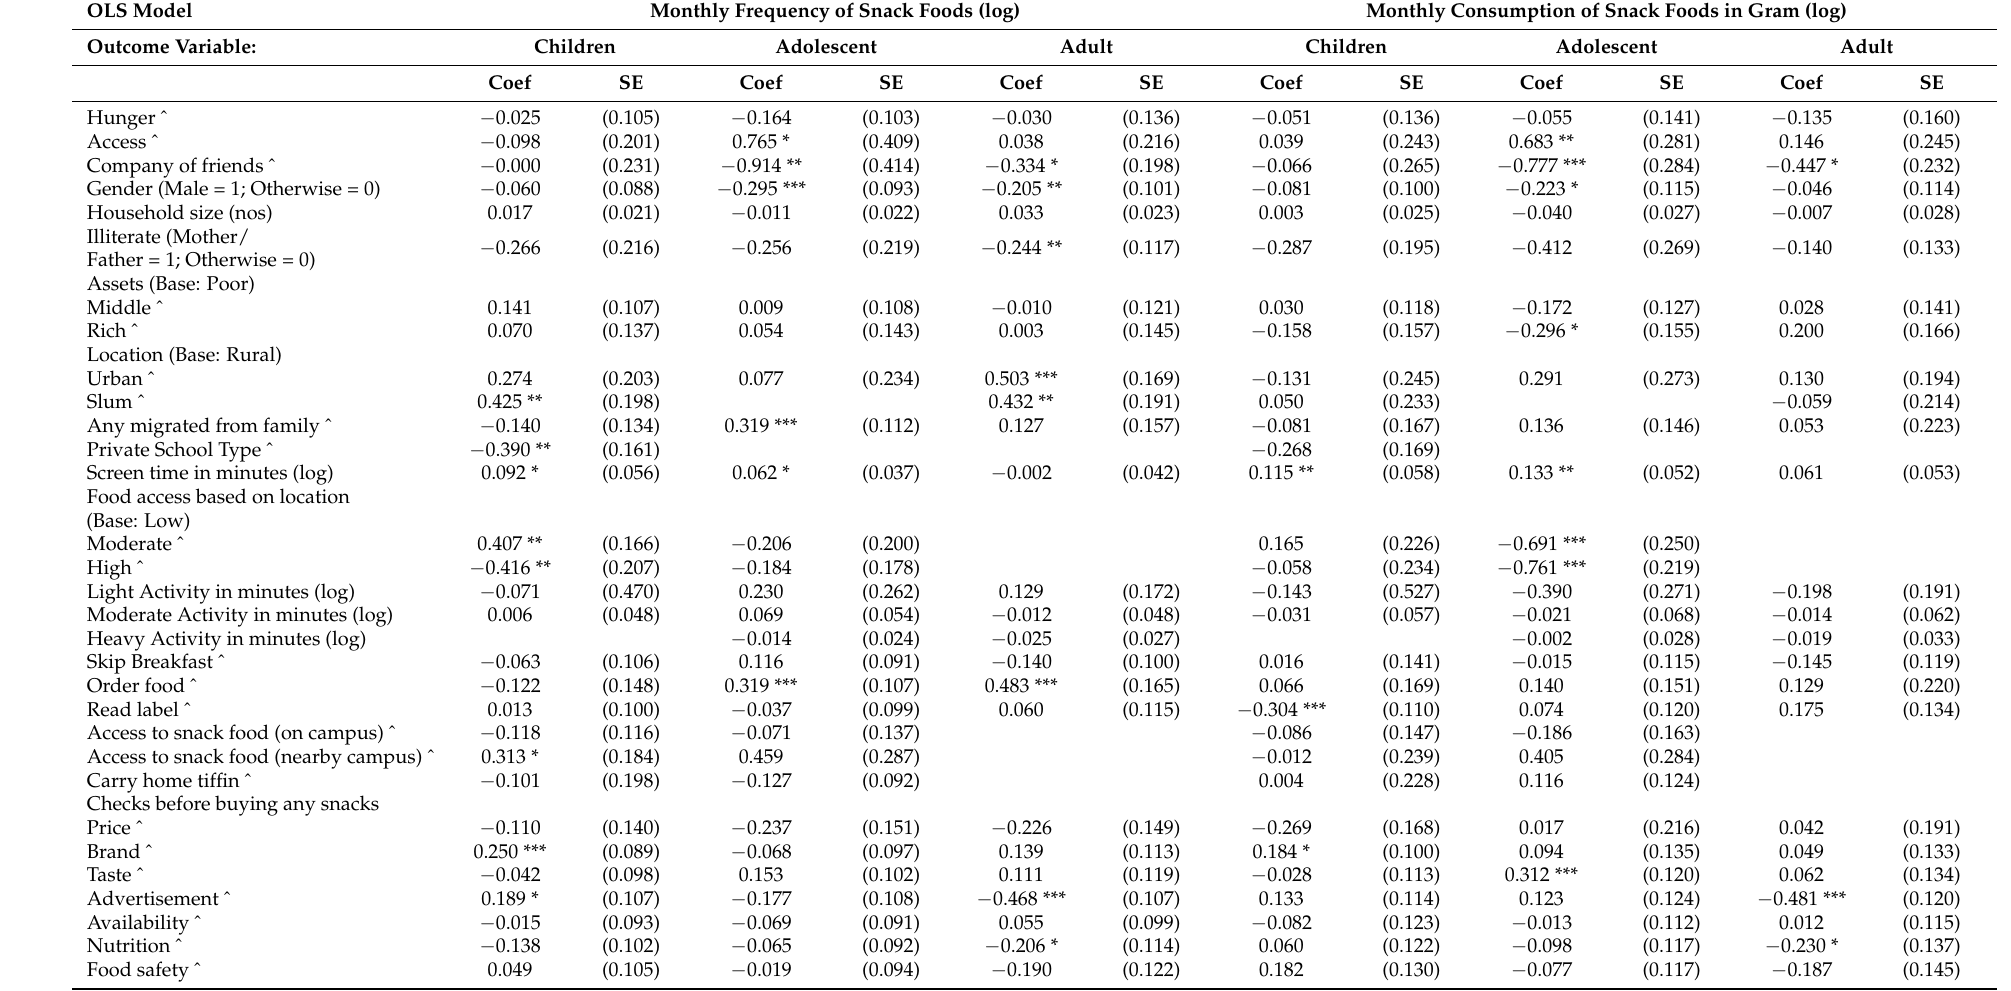
Table 2. Determinants of